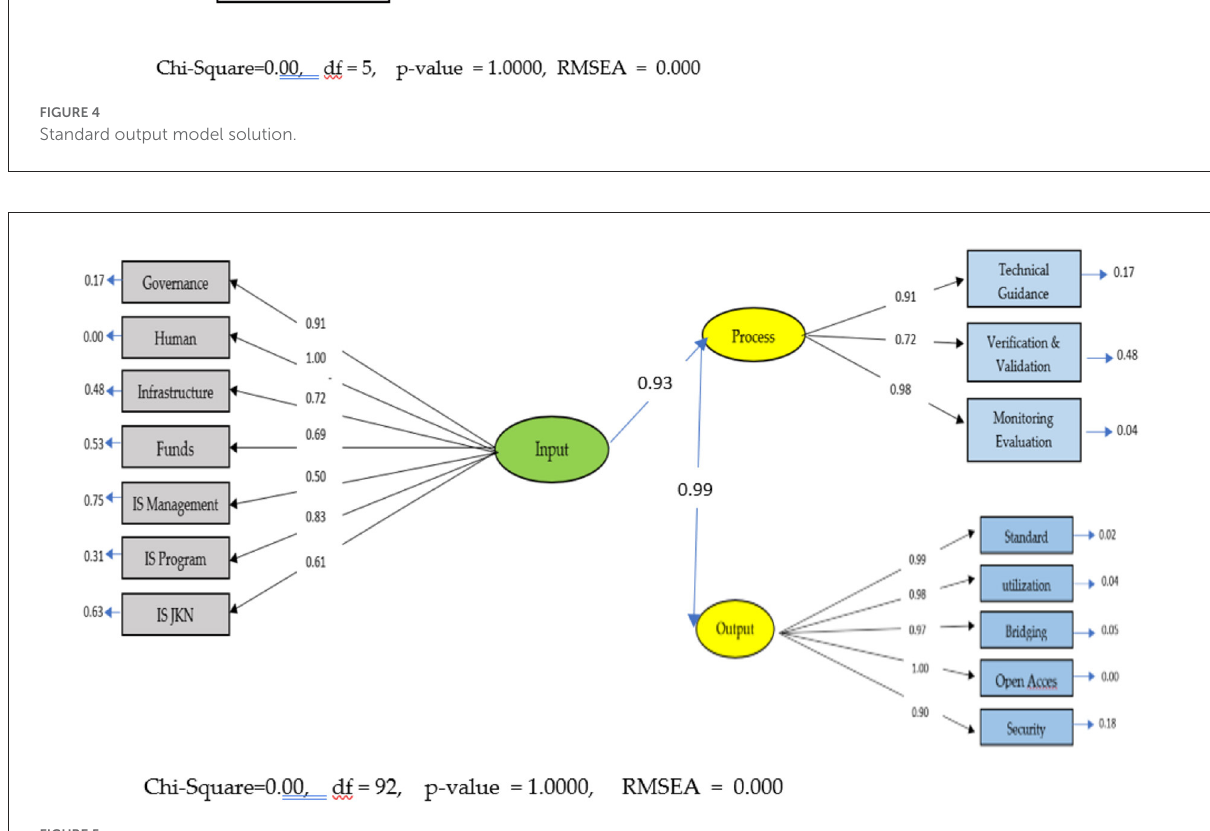
FIGURE5 Complete model standard